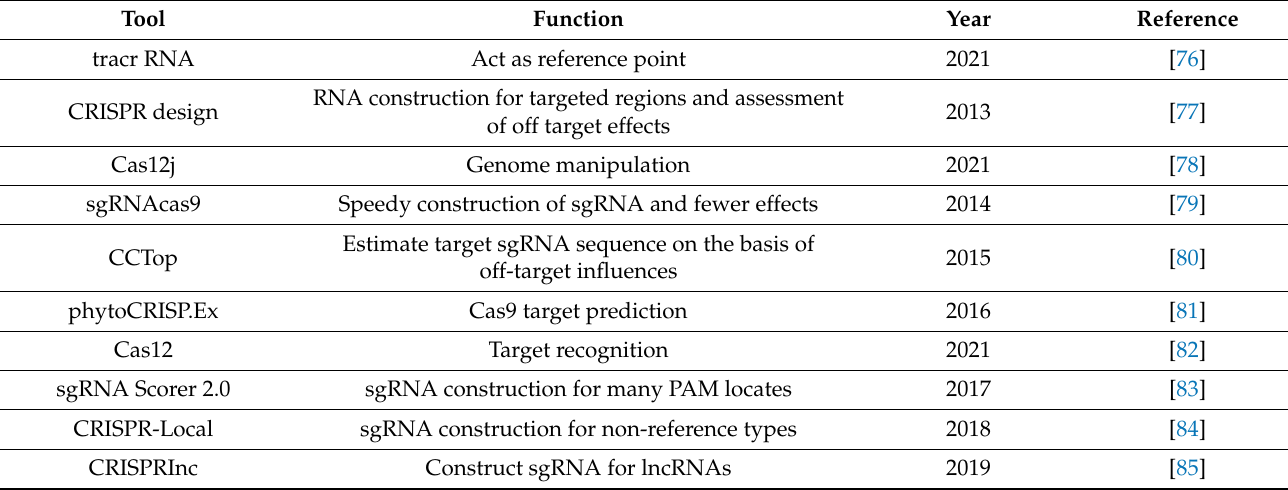
Figure 3. Mechanism of genome editing using Cas9. Cas9 gene-editing system involves complex of sgRNA and Cas9 protein, unwinding of DNA by sgRNA, cutting of gene by Cas9, use of analysis tools, cloning, and transformation, etc. This process needs no foreign element for editing. Table 3. RNA tools developed for CRISPR/Cas9. Tool